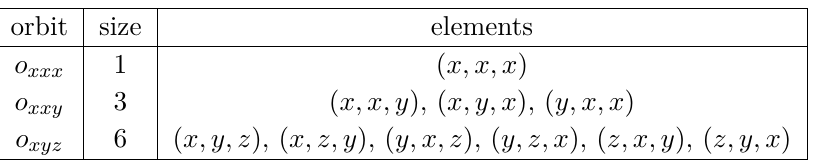
Table 7. Orbit types for the frame with d ref = ( n, n, n ) , where n 6 = 0 . Notation as in table 4, with